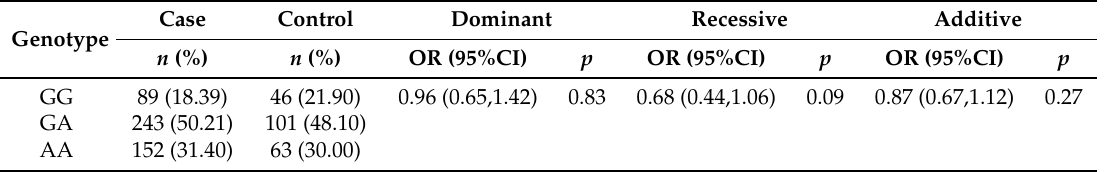
Table 3. Association between lncRNA CASC8 rs10505477 and lung cancer risk.